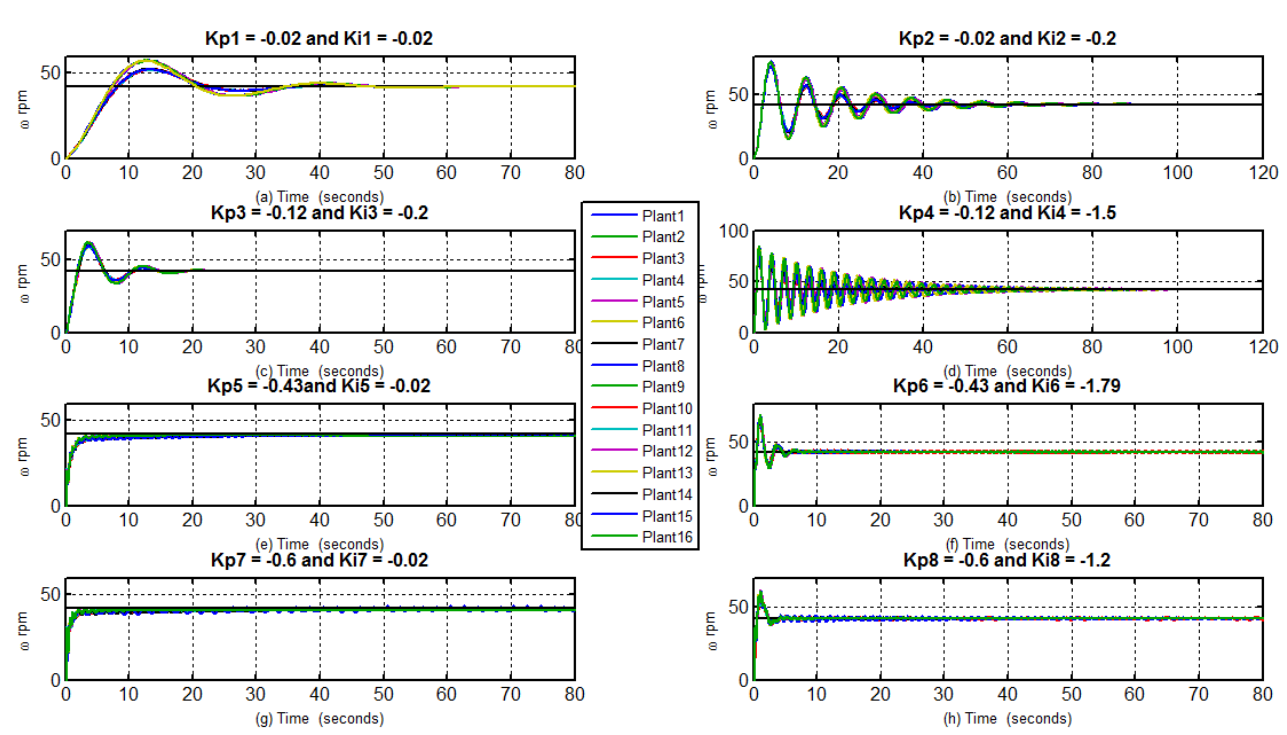
Figure 9. The step responses of 16-Kharitonov plants representing the regulation of speed to 42 rpm by the eight selected points considered for illustration. The points are taken from the Kp and Ki stabilizing region of Figure